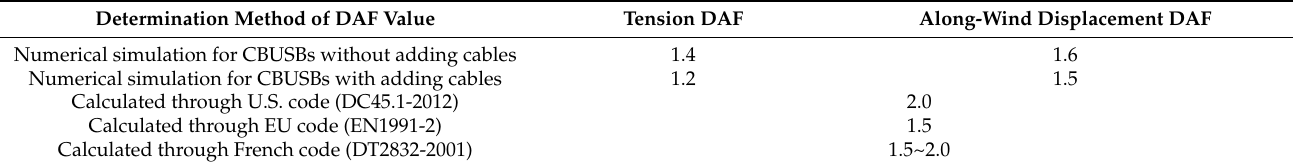
Table 6. DAF considering the influence of the cable